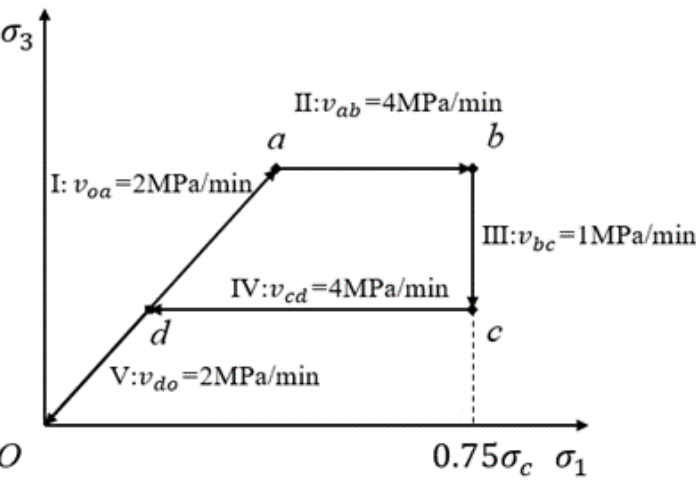
Figure 2 . Unloading test stress path ( σ c indicates peak triaxial strength). Figure 2. Unloading test stress path ( σ c indicates peak triaxial